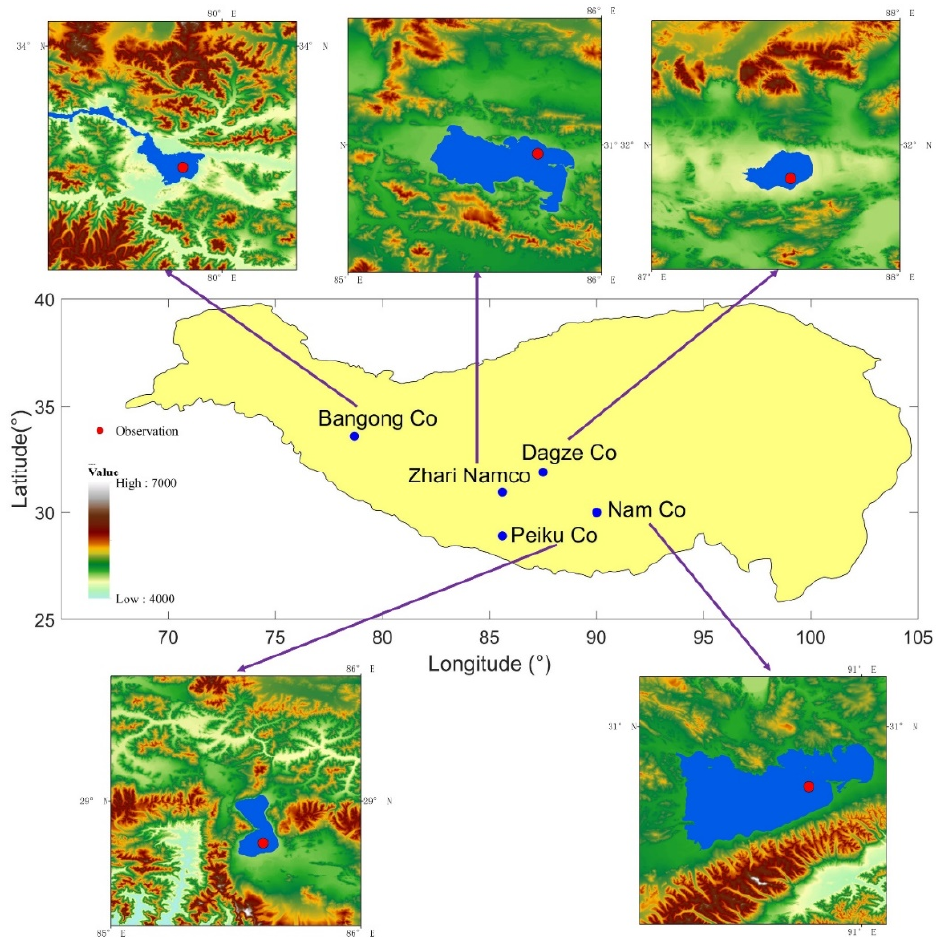
Figure 1. Location of five Tibetan Plateau lakes (Bangong Co, Zhari Namco, Dagze Co, Paiku Co, and Nam Co) and their surrounding topography (the red dots indicate water temperature monitoring stations).